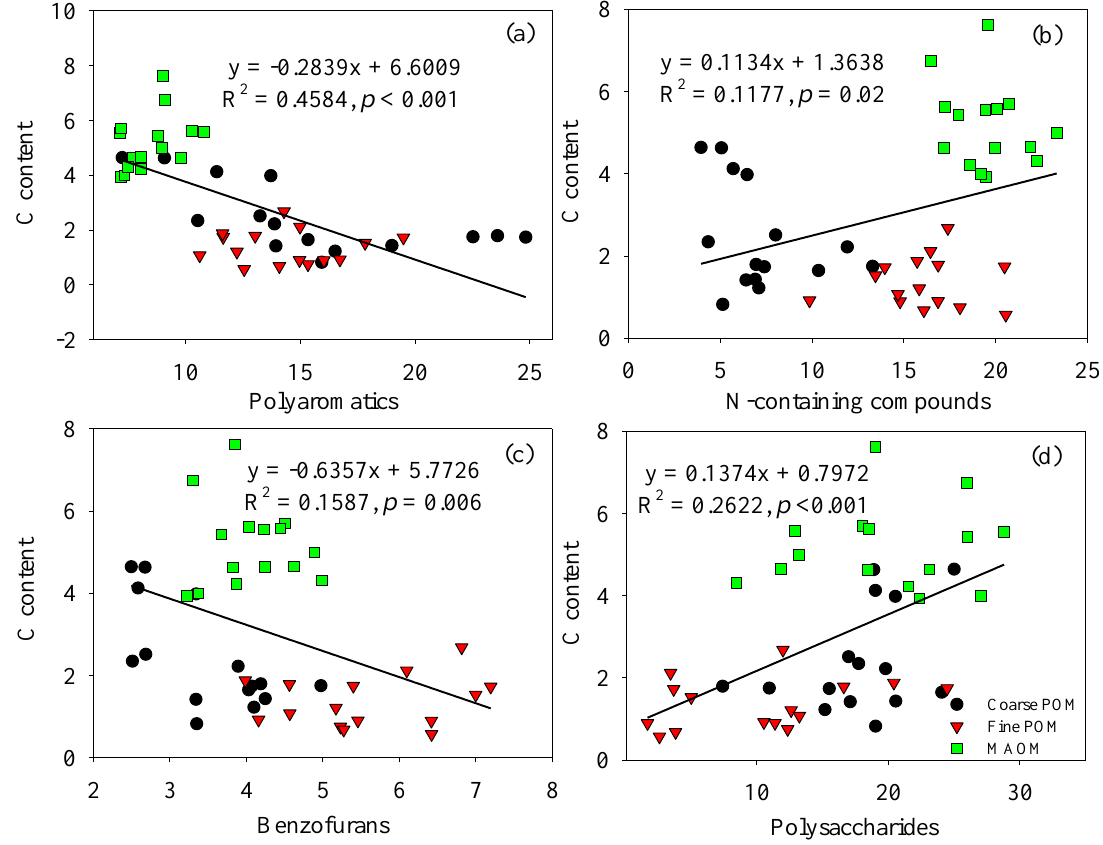
Figure 4. Relationships between C contents and chemical groups: ( a ) polyaromatics, ( b ) N-containing compounds, ( c ) benzofurans, and ( d ) polysaccharides in three particulate fractions.